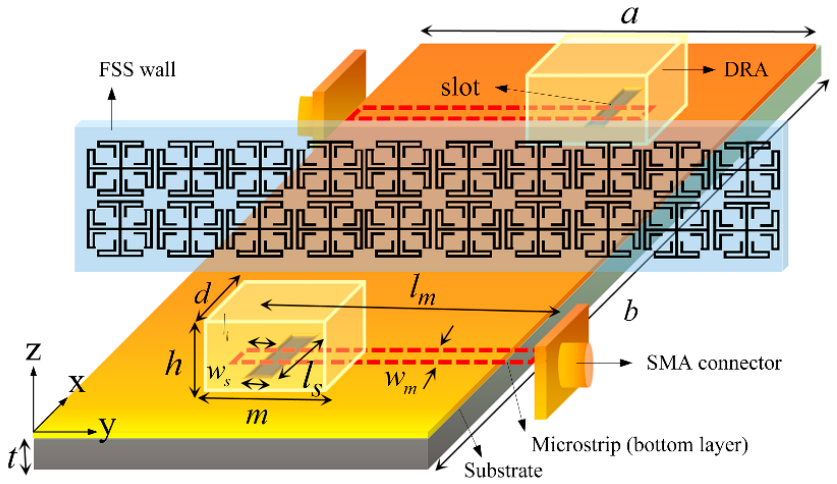
Figure 7. Schematic illustration of the 1 × 2 dielectric resonator antenna (DRA) multiple-input– multiple-output (MIMO) system with FSS wall. m = d = 14.5 mm, h = 7 mm, a = 35.5 mm, w m = 2.48 mm, l m = 20 mm, l o = 10 mm, l s = 13 mm, w s = 2 mm, t = 1.6 mm.